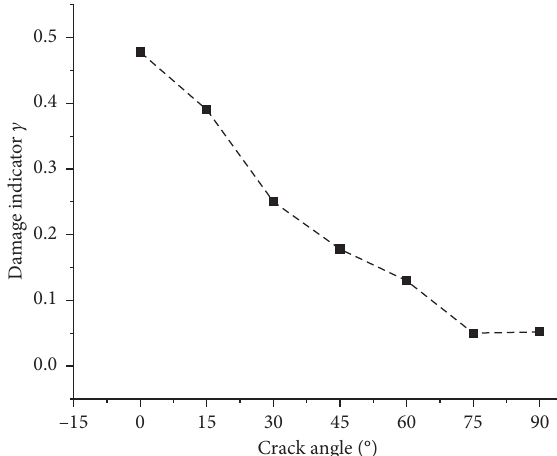
Figure 8: Distribution of damage indicator c for various crack angles.